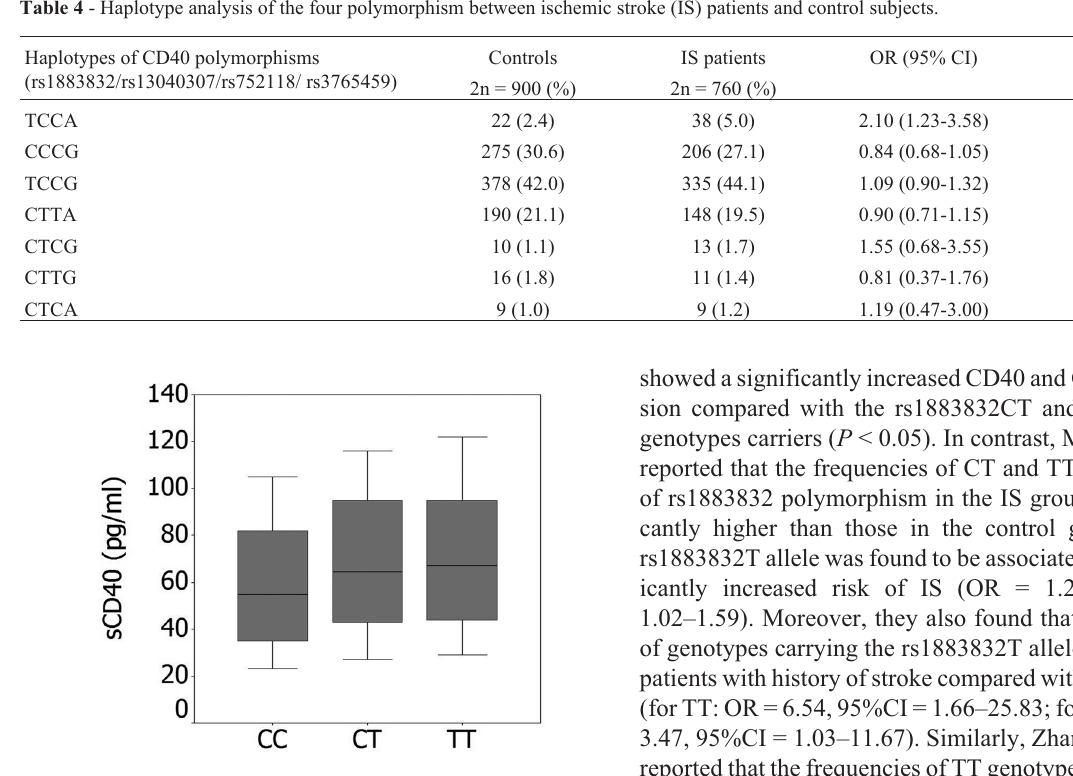
Figure 2 - Association between the CD40 rs1883832 polymorphism and sCD40 levels in IS patients. sCD40 levels were significantly lower in IS patients with rs1883832CC genotype than in rs1883832TT and rs1883832CT genotypes. However, there were no significant differences in sCD40 levels between the rs1883832CT and TT genotypes.